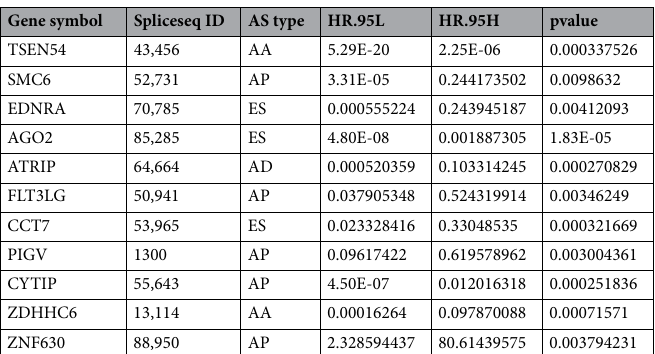
Table 2. Mutivariate Cox analysis of prognostic AS predicting overall